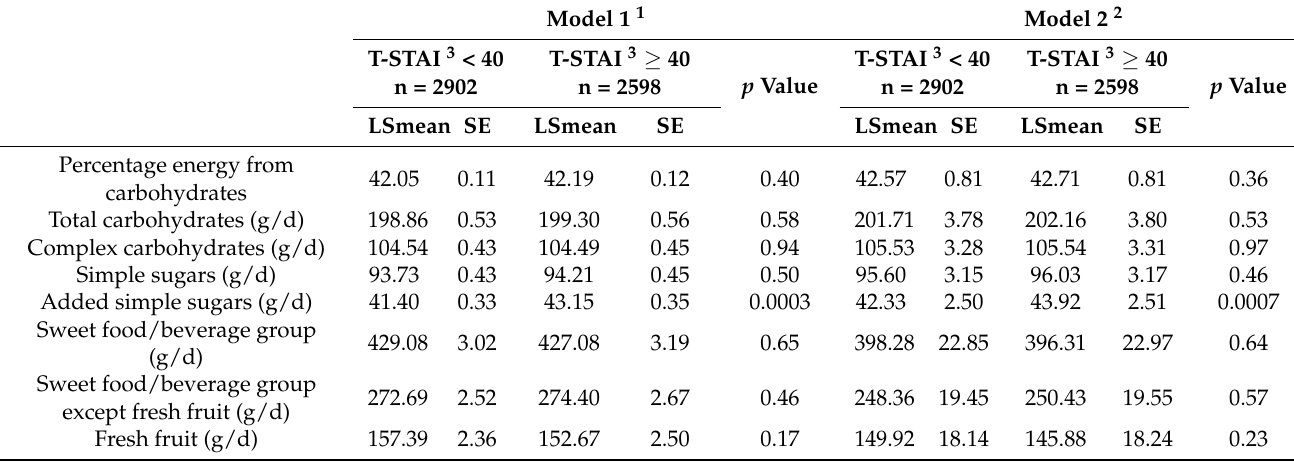
Table 2. Comparison of mean daily intake of sugar between high and low trait anxiety groups (non-diabetic adults aged <45 years; n = 5500).